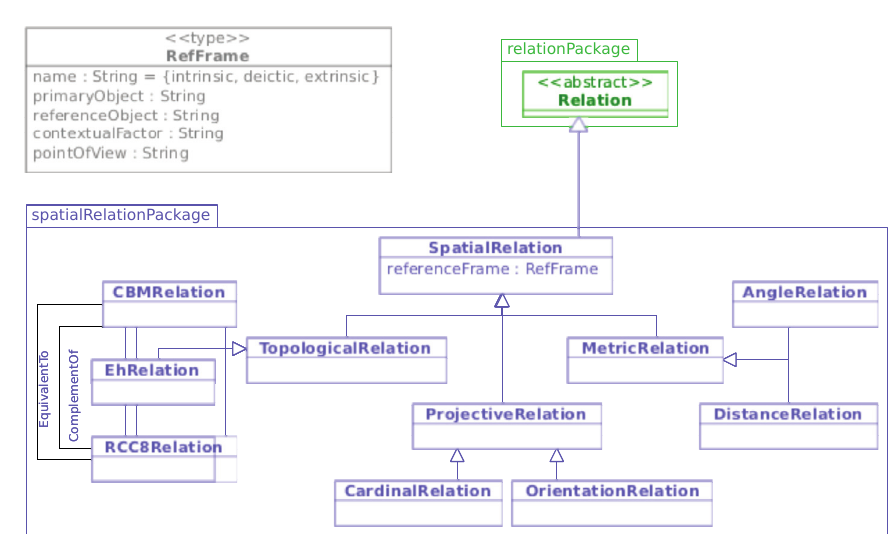
Figure 7: Spatial relation